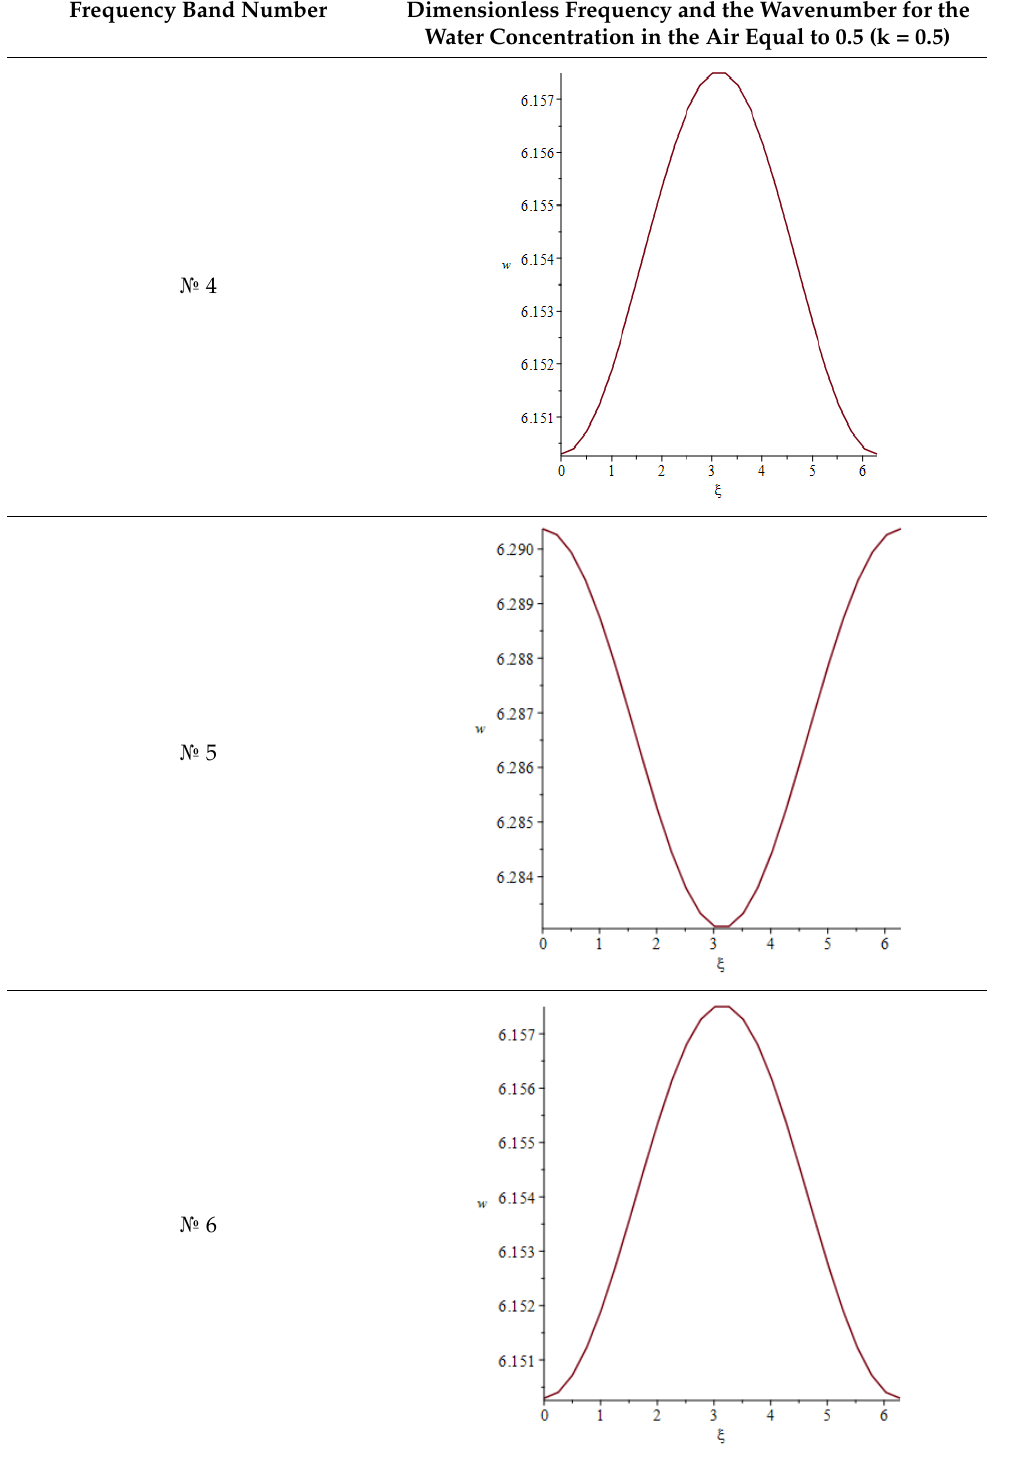
Table 3. Cont. Graphs of the Dispersion Relations for the Frequency Band Number Dimensionless Frequency and the Wavenumber for the Water Concentration in the Air Equal to 0.5 (k = 0.5)